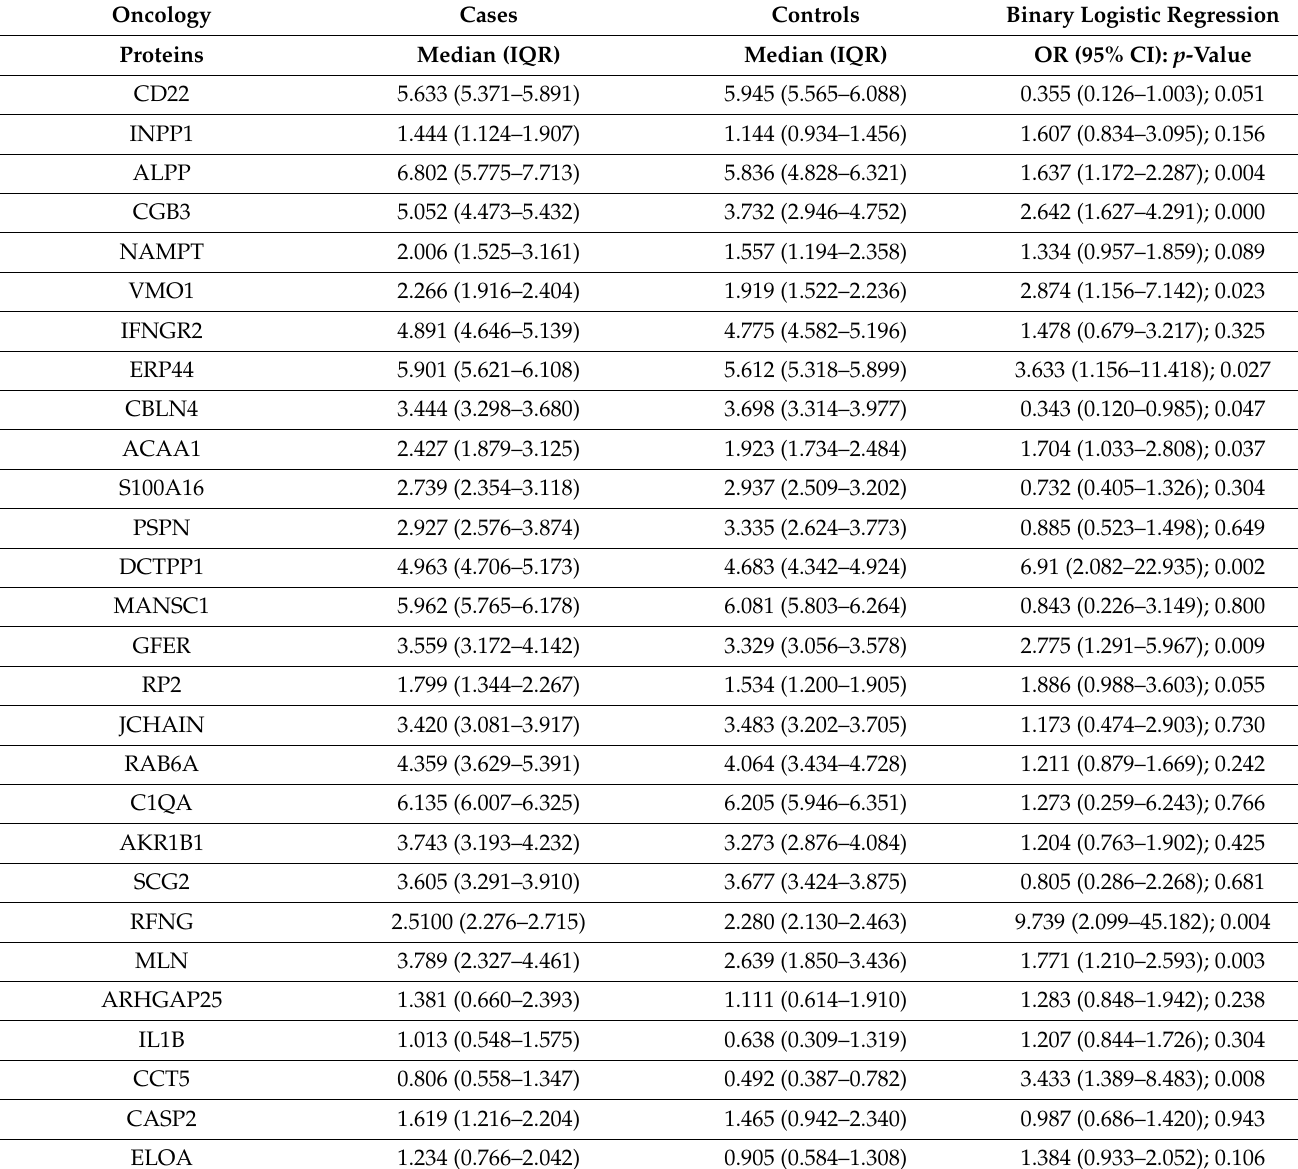
Table 5. Oncology panel: result of descriptive analysis, and binary logistic regression against the